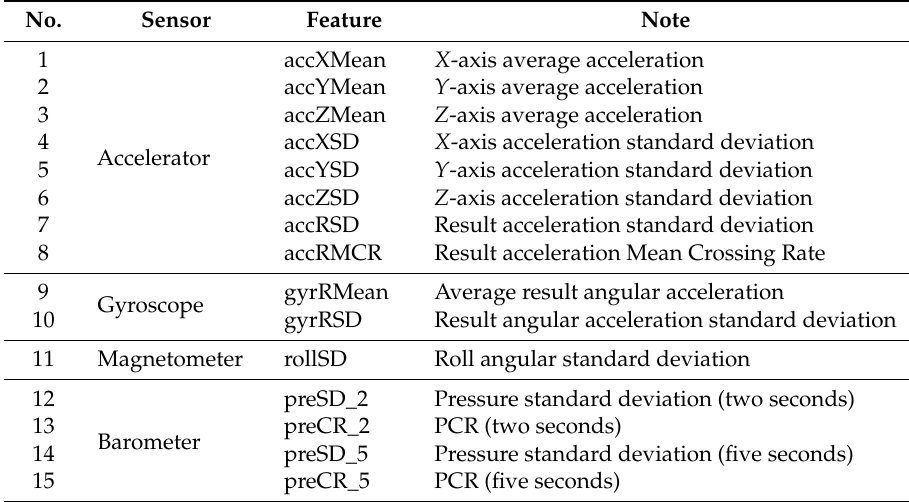
Table 2. Multi-sensor features used in motion